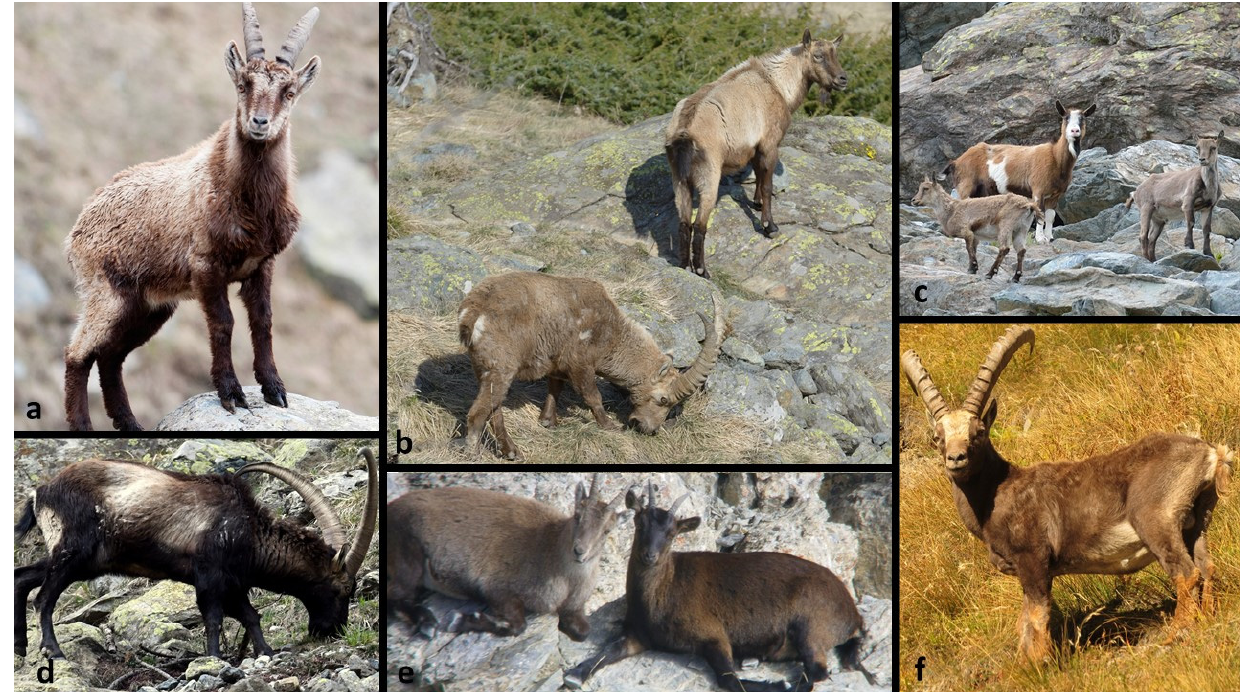
Figure 1. Examples of visual documentation provided as evidence of probable hybridization events (Q2) and of feral goats. ( a ) probable hybrid with deviations of the coat color and abnormal horns and body morphology. Origin: Balme, Piedmont (Italy). Photo Copyright: Simone Miotto. ( b ) probable hybrid (on the right), hornless and with deviations of the coat color, and an Alpine ibex (on the left). Origin: Balme, Piedmont (Italy). Photo Copyright: Luca Giordano. ( c ) female goat in the centre and two hornless young with deviations of the coat color (classified as probable hybrids). Origin: Balme, Piedmont (Italy). Photo Copyright: Luca Giordano. ( d ) probable hybrid with deviations of the coat color. Origin: Balme, Piedmont (Italy). Photo Copyright: Giuseppe Castelli. ( e ) probable hybrid with deviations of the coat color and horns, and abnormal body morphology (on the right), and an Alpine ibex on the left. Origin: Entraunes, Alpi Marittime (France). Photo Copyright: Martin Dhermont. ( f ) probable hybrid with deviations of the coat color. Origin: Bellino, Piedmont (Italy). Photo Copyright: Omar Giordano.